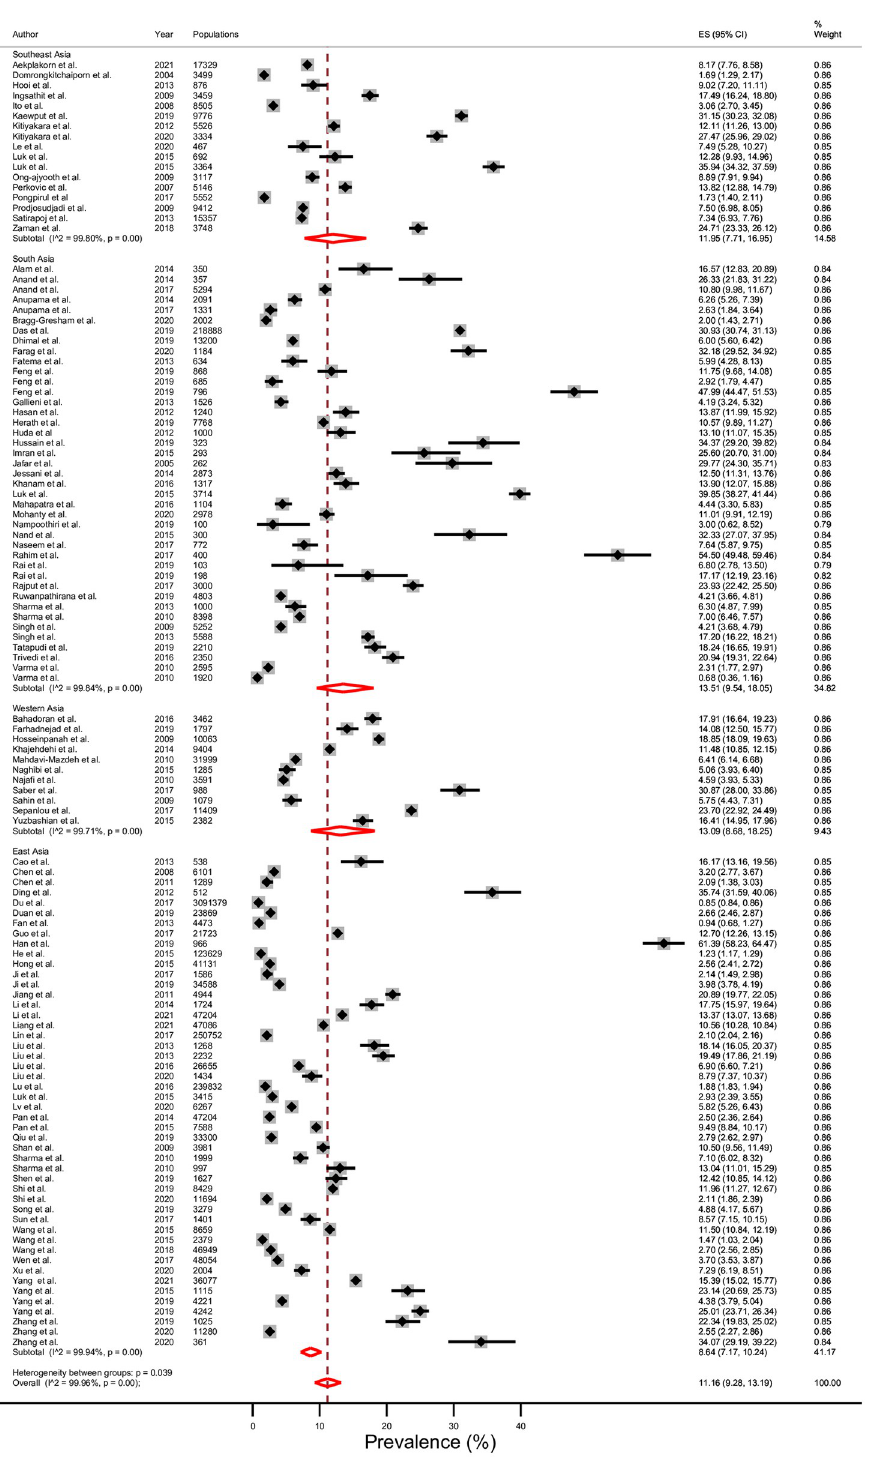
Fig 3. Prevalence of chronic kidney disease (CKD) stages 3–5 in low- and middle- income countries (LMICs) according to subregion of Asia using a random-effects model.